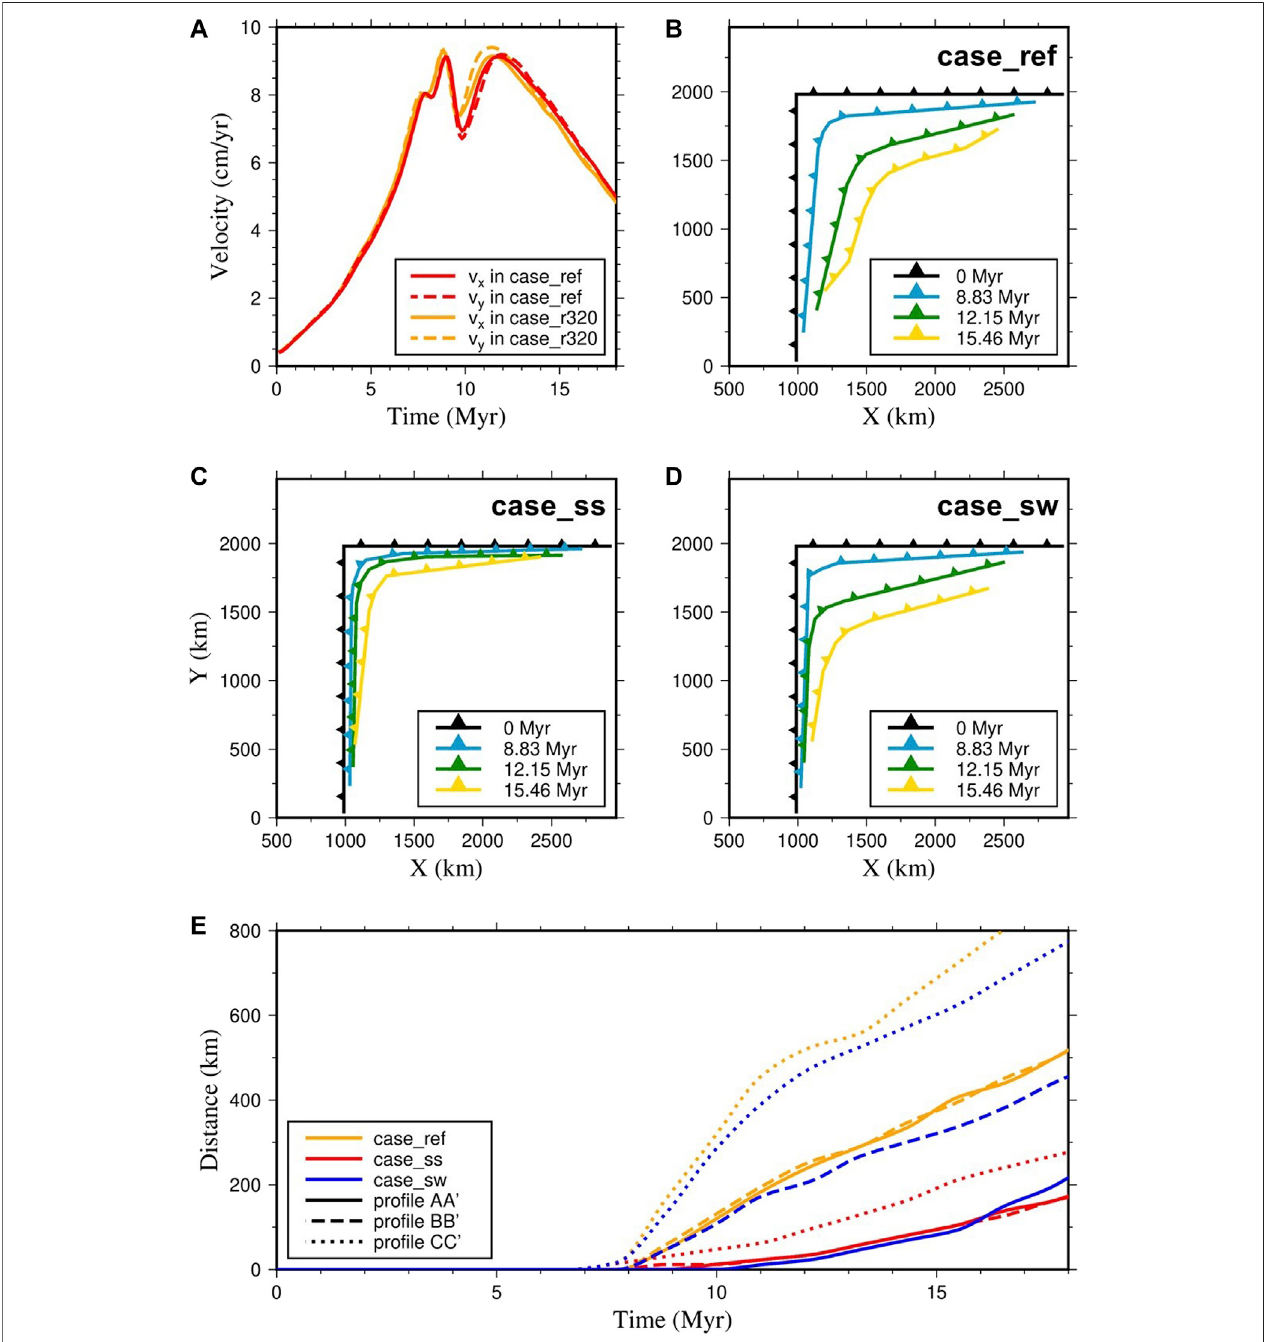
FIGURE 5 | (A) The velocities of the subducting plate in the X ( v x , solid line) and Y ( v y , dashed line) directions. Red and orange colors show the results of case_ref andcase_320,respectively. (B) , (C) ,and (D) showthetrenchmigrationhistoryincase_ref,case_ss,andcase_sw,respectively. (E) Themigrationdistancesofthetrench along pro fi les AA ’ (solid line), BB ’ (dashed line), and CC ’ (dotted line) in Figure 2A . Orange, red, and blue colors show the results of case_ref, case_ss, and case_sw, respectively.